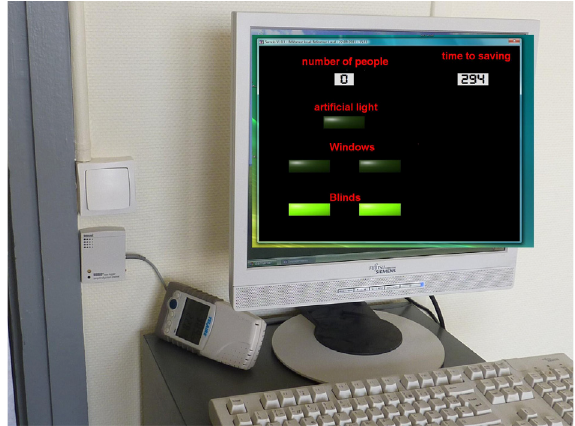
Fig. 2. The building occupancy manual acquisition system.